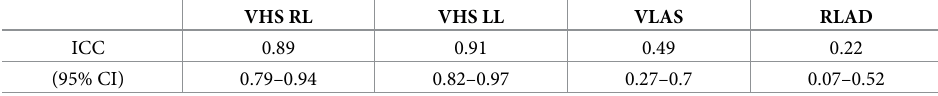
Abbreviations: CI, confidence interval; RLAD, radiographic left atrial dimension; VHS RL/LL, vertebral heart score right lateral/left lateral recumbency; VLAS, vertebral left atrial